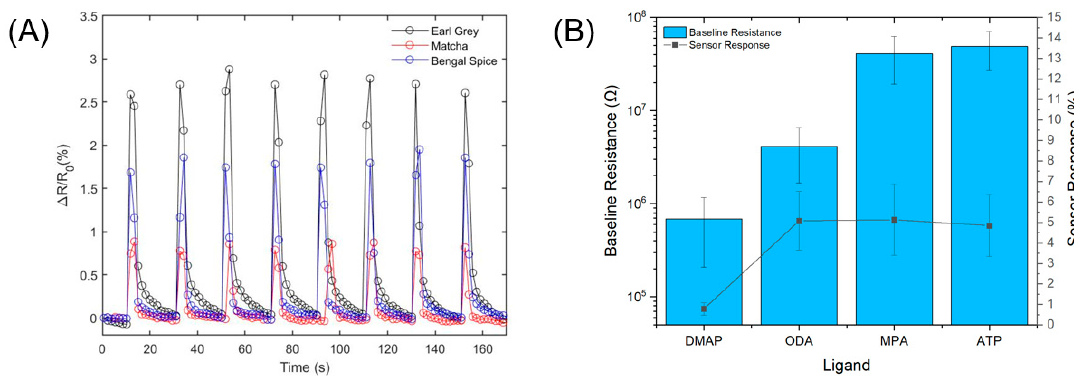
Figure 3. ( A ) Real-time sensor response profiles for Earl Grey (black tea), Matcha (green tea), and Bengal Spice ® (herbal tea) for one sensor element with DMAP-AuNP; ( B ) Baseline resistance and sensor response variation among four types of organo-capped gold nanoparticles toward Black Cherry Berry (herbal tea).